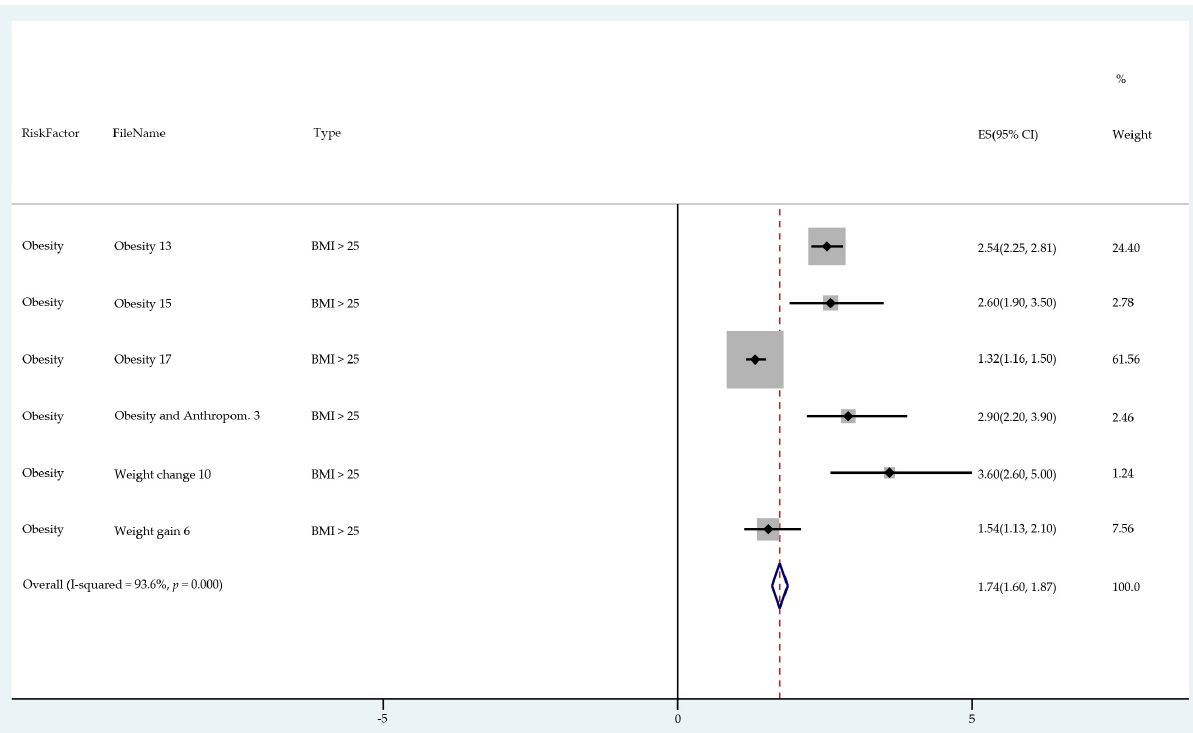
Figure 1. Forest plot to show risk of BMI > 25.